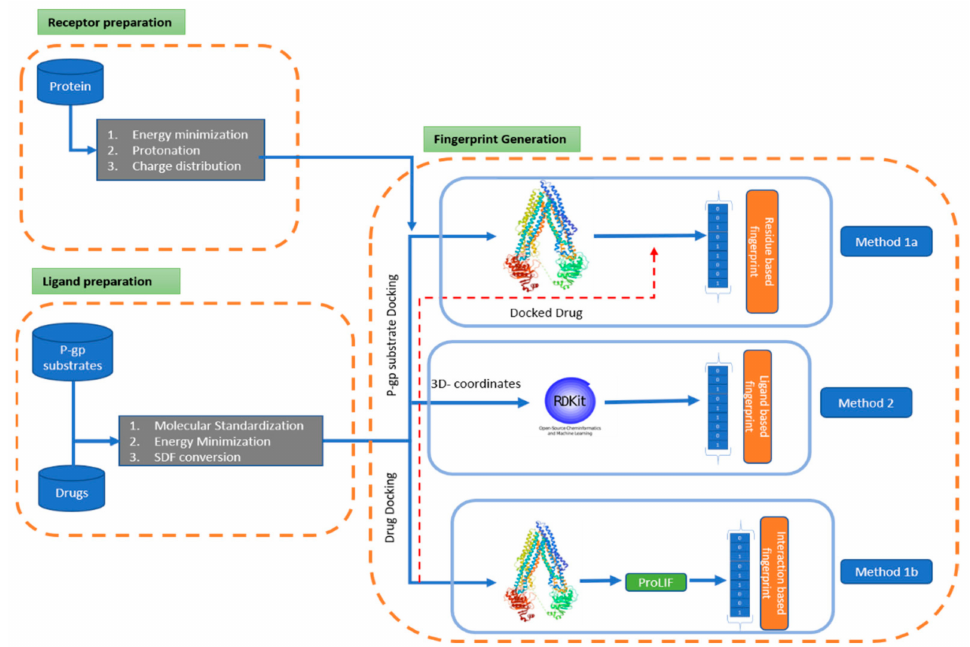
Figure 1. Methodological framework for pharmacophore generation. First, the protein is passed through a pre-processing phase, which includes energy minimization, protonation, and the distri- bution of charges. Along with this, drugs and P-gp substrates are standardized and finally passed through the energy minimization process to obtain a stable 3D structure. Using these pre-processed data, three types of fingerprints are generated. 1a. Residue-based fingerprint: P-gp substrates are docked and interacting amino acids are extracted; simultaneously, the docked drug interaction residues are mapped over it to generate a fingerprint. Red-dashed arrow represent mapping of docked-drug interaction residues with P-gp interaction residues.1b. Interaction-type fingerprint: drug molecules are docked, and then the docked data are processed with the ProLIF library 2. Ligand-based Fingerprint: drug data, along with 3D coordinates, are processed in